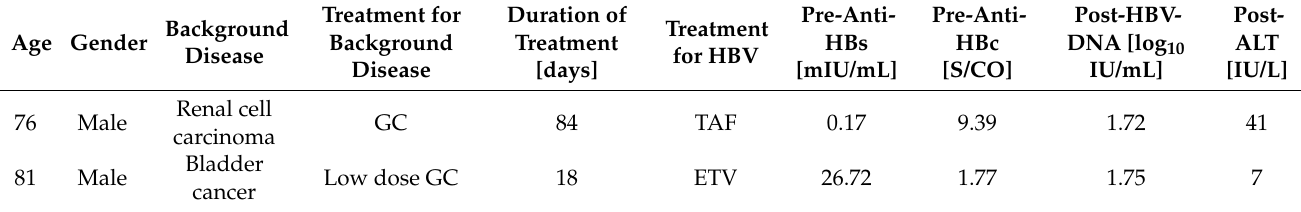
Table 3. Clinical characteristics of patients with HBV reactivation in the remission